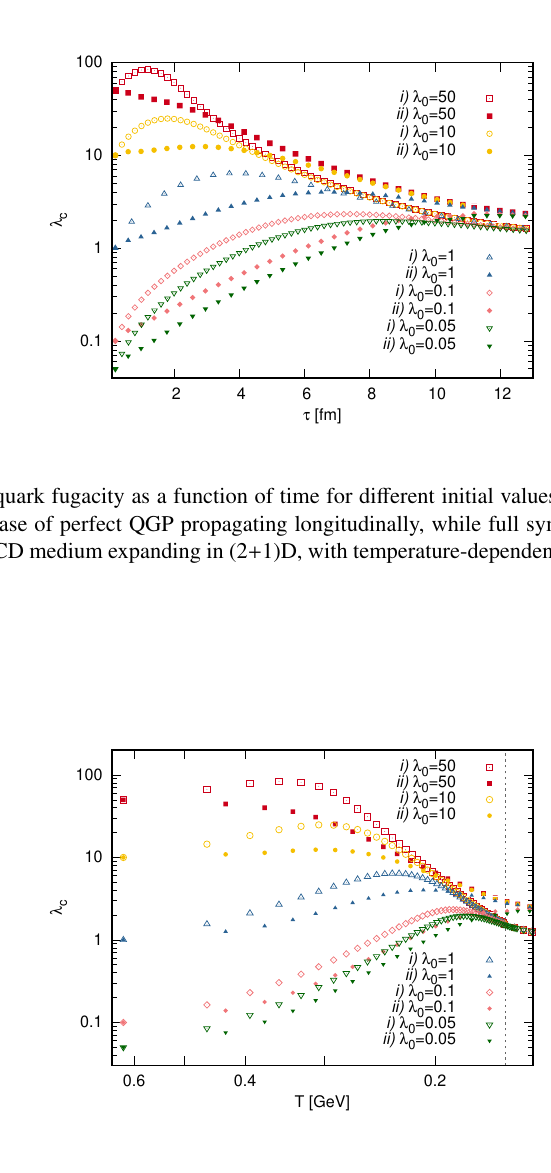
Figure 3. Charm quark fugacity λ c as a function of temperature for di ff erent initial values λ 0 . The sym- bols and colors correspond to that in Fig. 2. The dashed line represents the pseudocritical